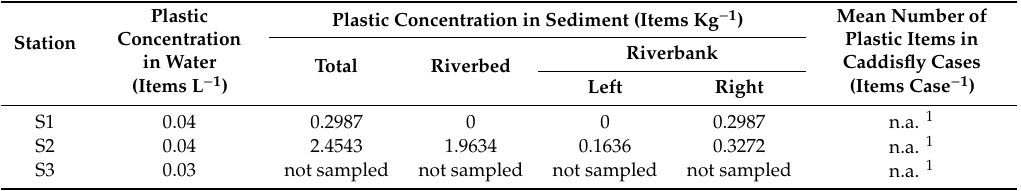
Table 3. Plastic concentration in water, sediments and caddisfly cases along River